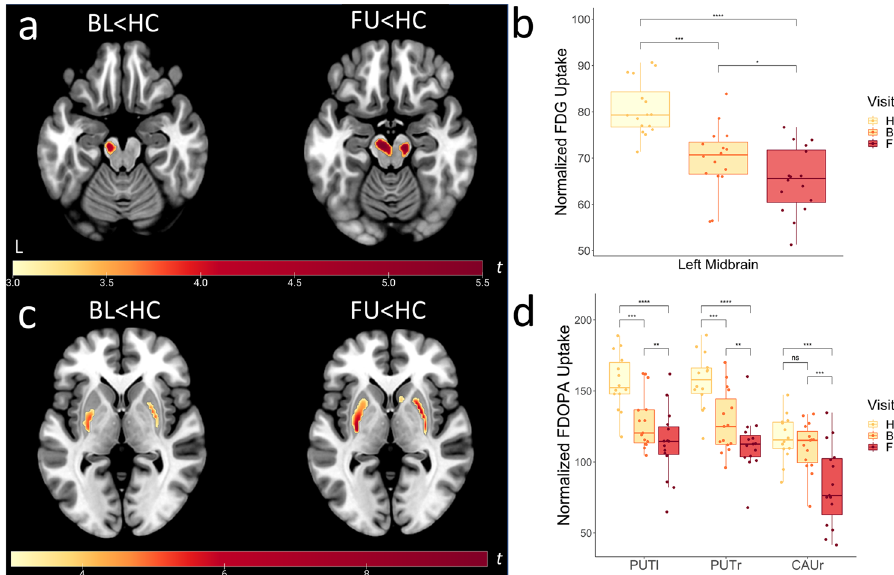
Fig. 1 Between-group differences in FDG and FDOPA uptake versus healthy controls. T-maps were generated in SPM12 by voxel-vise t - tests with the above displayed contrasts. a Patients with Parkinson ’ s disease showed FDG hypometabolism at baseline and follow-up visit in comparison to healthy controls. Extracted normalized FDG uptake ( b ) and FDOPA uptake ( d ) values from respective clusters (FU < HC) are shown as boxplots with individual data points in a direct comparison between baseline, follow-up, and healthy controls (* p < 0.05, ** p < 0.01, *** p < 0.001, **** p < 0.0001, central line = median, bounds of box = 25th to 75th percentile, whiskers = smallest to highest value within 1.5 times interquartile range below 25th percentile respectively above 75th percentile). c Patients exhibited dopaminergic de fi cits in the bilateral posterior putamen compared to healthy controls at both visits. Results are shown at p FWE < 0.05 cluster-level corrected using SVC for a midbrain ( a ) or striatum ( c ) ROI. T -values of resulting clusters are indicated by the colorbar. Boxplots contain extracted normalized FDG and FDOPA values with proportional scaling. BL = baseline, FU = follow up, HC = healthy controls, PUTl = left putamen, PUTr = right putamen, CAUr = right caudate